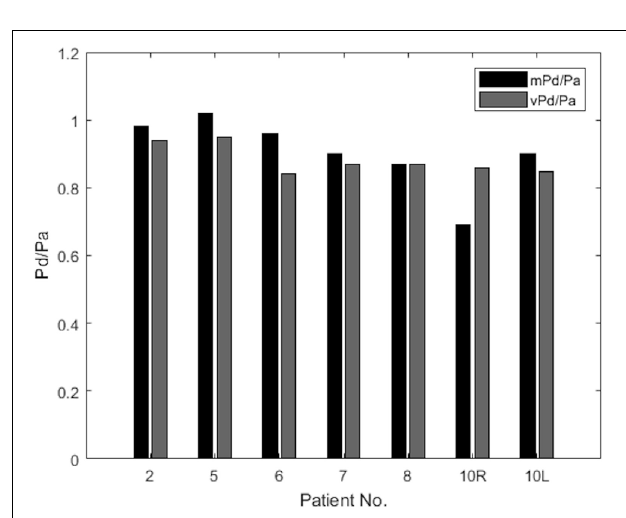
FIGURE 6 | Measured versus virtual